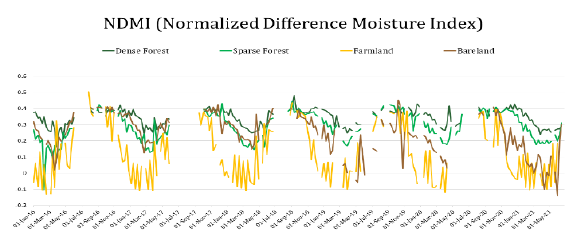
Fig. 4: Mean NDMI for 30 random points taken in each land cover class of Mizoram area from year 2016-2021.